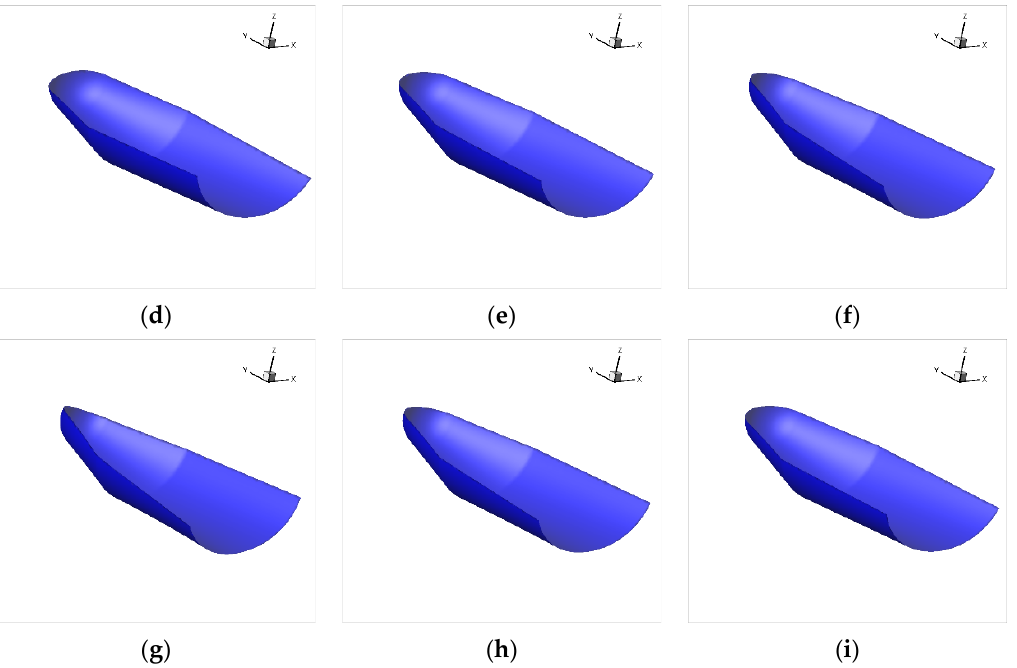
Figure 15. Diagram of deformation of the fairing in one cycle: ( a ) 1/9 T, ( b ) 2/9 T, ( c ) 3/9 T, ( d ) 4/9 T, ( e ) 5/9 T, ( f ) 6/9 T, ( g ) 7/9 T, ( h ) 8/9 T, and ( i ) T.